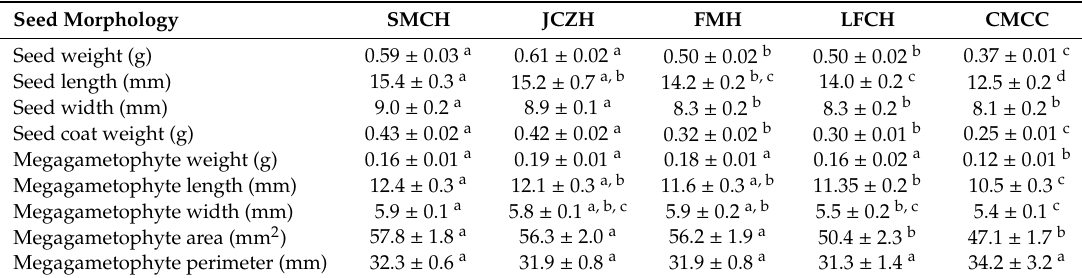
(Table 1). San Miguel Tlazintla, Cardonal, Hidalgo (SMCH) and Jagüey Colorado, Zimap á n, Hidalgo (JCZH) populations presented the highest values in unshelled seed (i.e., weight, length, and width), seed coat weight, and shelled seed (i.e., megagametophyte weight, length, width, area, and perimeter) (Table 1); while the La Florida, Cardonal, Hidalgo (LFCH) and Fontezuelas, Metztitl á n, Hidalgo (FMH) populations presented intermediate values of seed trail, and finally, the Curvas de Malpaso, Cuauht é moc, Chihuahua (CMCC) population had the lowest values. Table 1. Seed morphology from five populations of P. cembroides . Seed